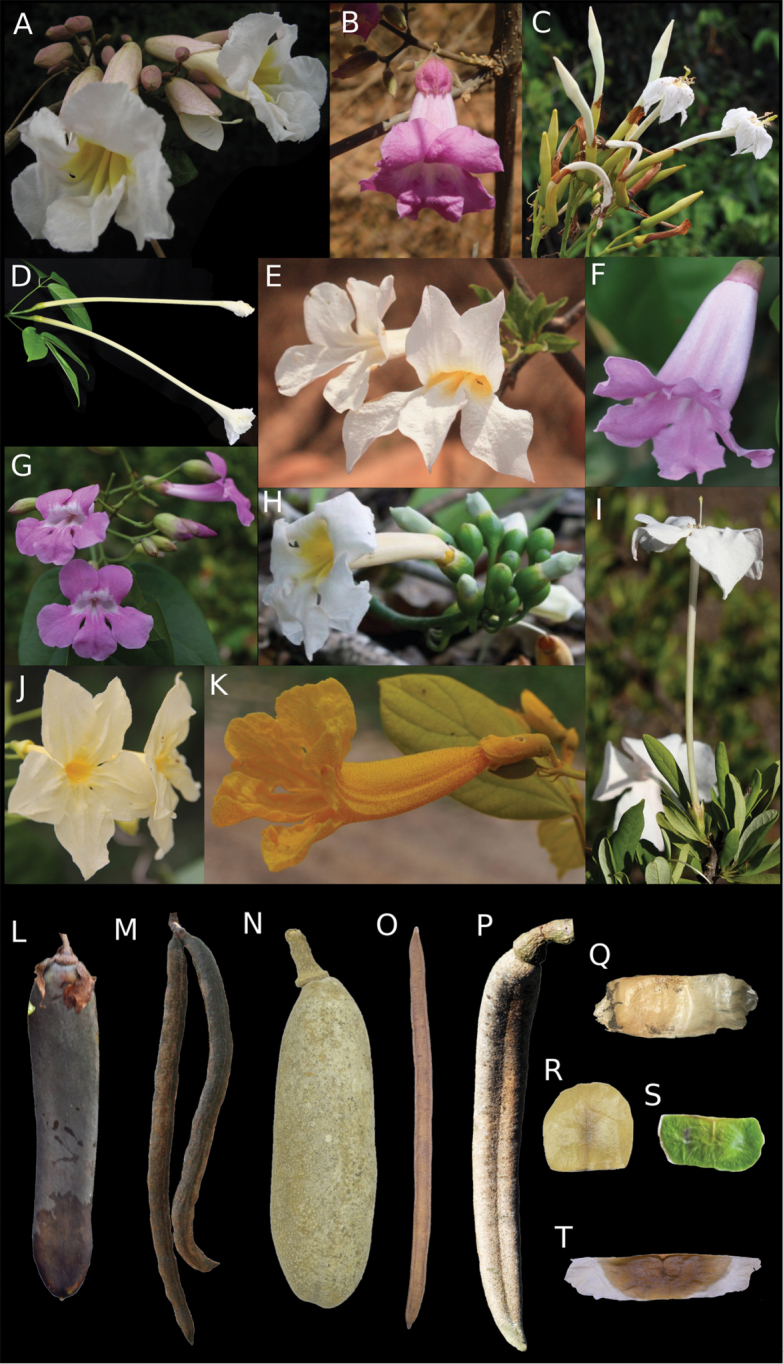
Morphological diversity of Tanaecium. A–K Flowers AT.
bilabiatumBT.
dichotomumCT.
duckeiDT.
jarobaET.
parviflorumFT.
pyramidatumGT.
revillaeHT.
tetragonolobumIT.
tetramerumJT.
truncatumKT.
xanthophyllum.L–P Fruits LT.
bilabiatumMT.
cyrtanthumNT.
jarobaOT.
selloiPT.
tetragonolobum. Q–T Seeds QT.
cyrtanthumRT.
jarobaST.
revillaeTT.
selloi. Photos by A. Frazão, except A by B. Gomes B by R. Lopes E, M by C. Siniscalchi G by E. Kataoka H by Stevens I by Parada-Gutierrez J by L.H.M. Fonseca.